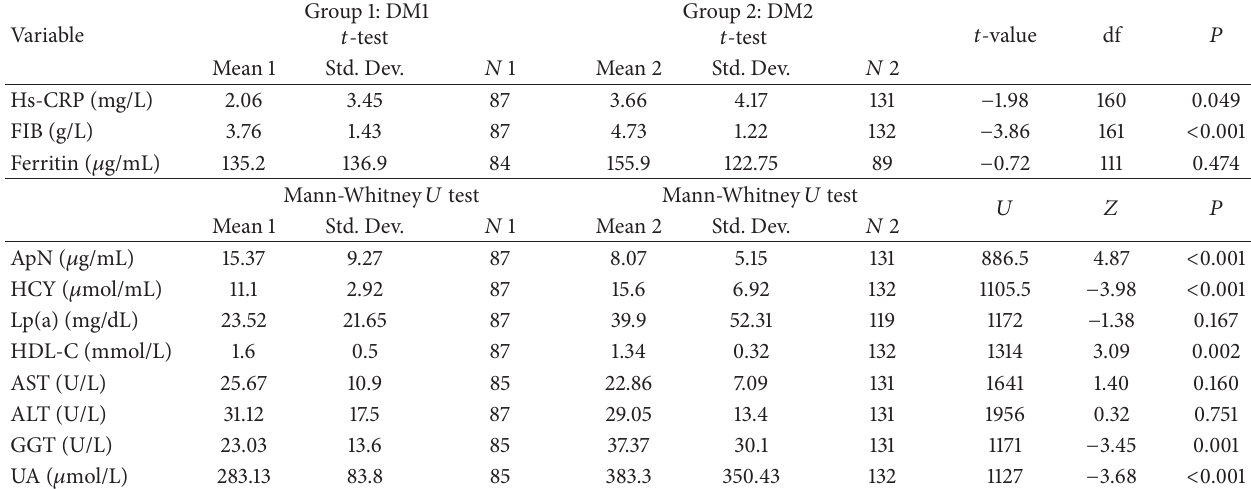
Table 1: Differences between biochemical data of the study groups according to type of diabetes.